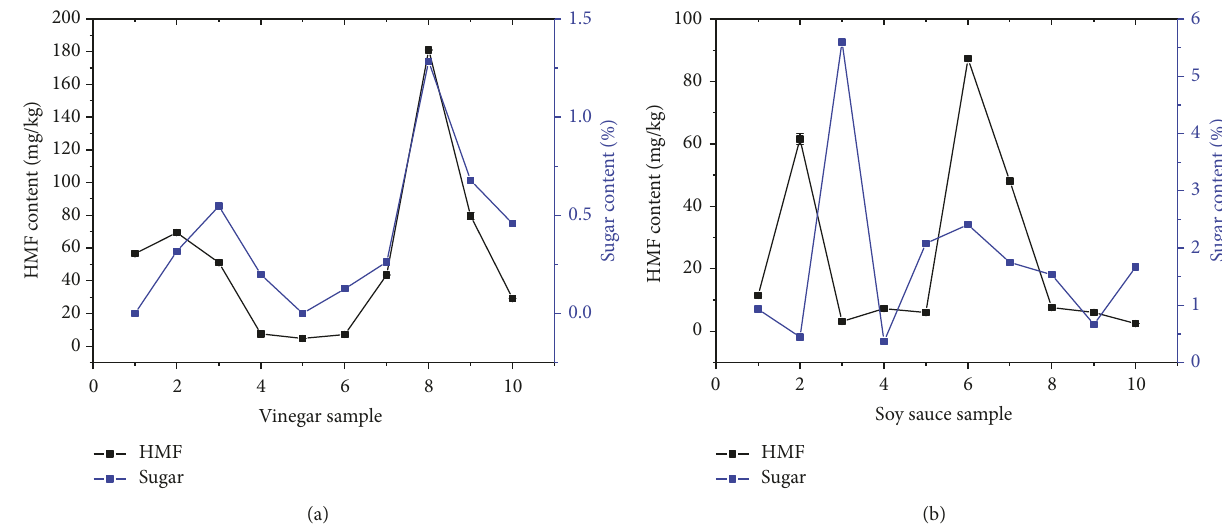
Figure 2: 5-Hydroxymethylfurfural (HMF) and sugar contents in vinegar (a) and soy sauce (b) samples.